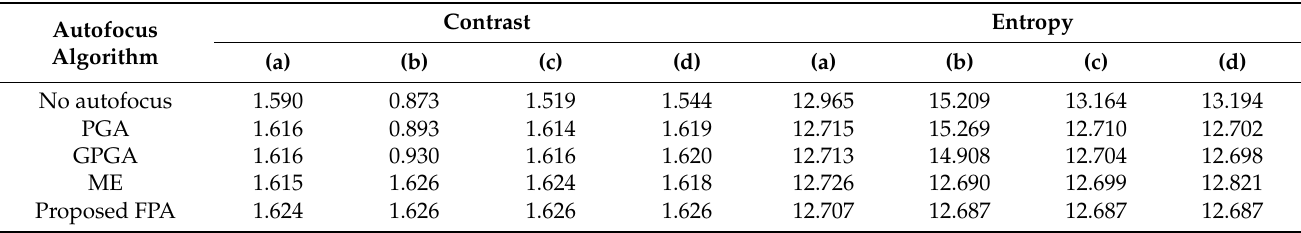
Figure 10. Additional scene to verify the reliability of FPA: ( a ) scene A and ( b ) scene B. Table 4. Comparison of performance for different autofocus algorithms for scene A.